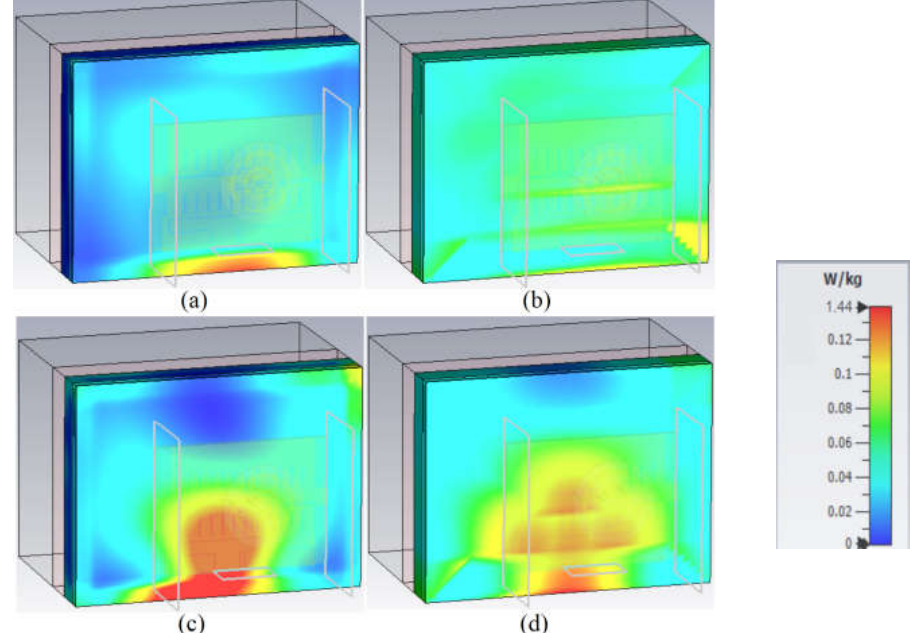
Figure 16. SAR evaluation of the proposed antenna at the proximity of human body tissue (( a ) at 3.4 GHz, 1 g; ( b ) at 3.4 GHz, 1 g; ( c ) at 5.6 GHz, 10 g; ( d ) at 5.6 GHz, 10 g).